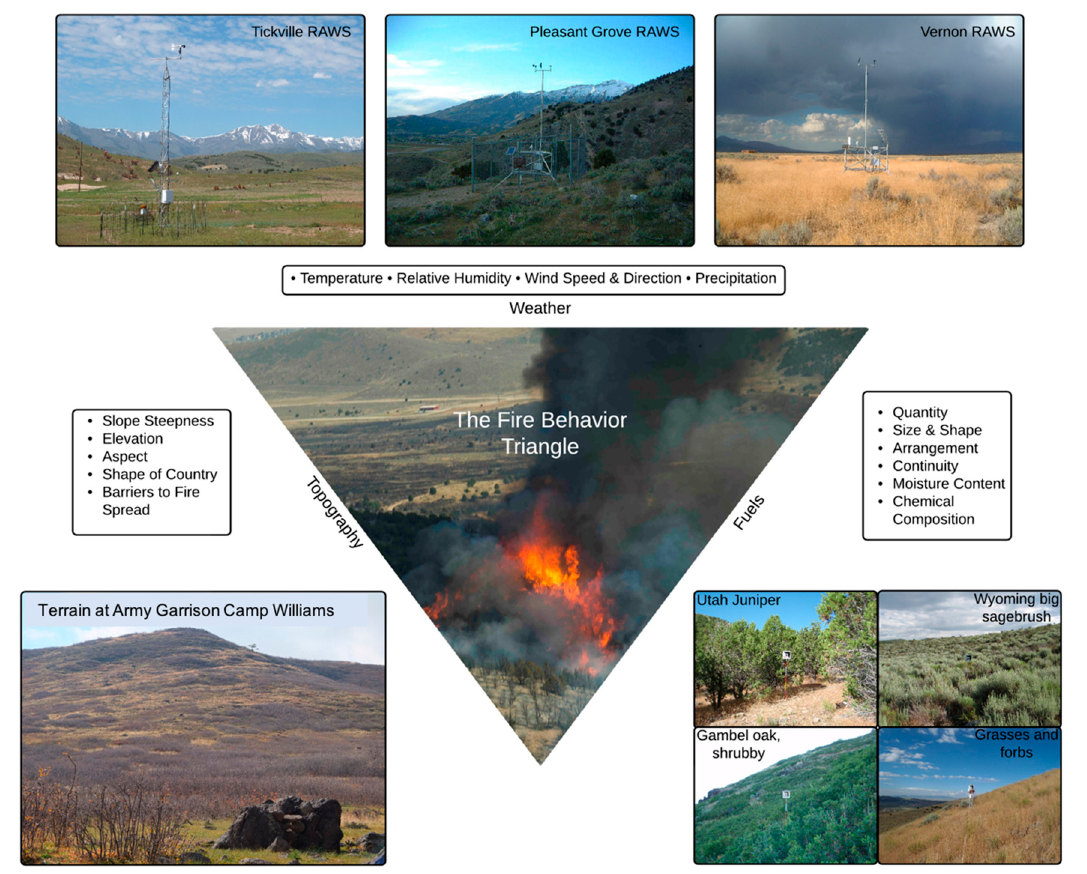
Figure 1. Photos of the fuels (lower right), weather (upper), and topography (lower left) at Army Garrison Camp Williams illustrating the three components of the fire environment triangle [3] that in turn form the fire behavior triangle as outlined by [1].